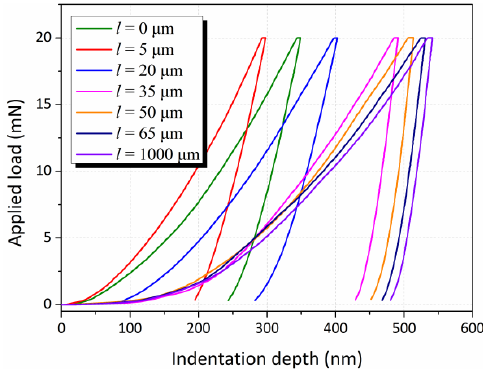
Figure 7. Nanoindentation load–displacement curves of the gas nitriding wheel specimen at different distances l from the top